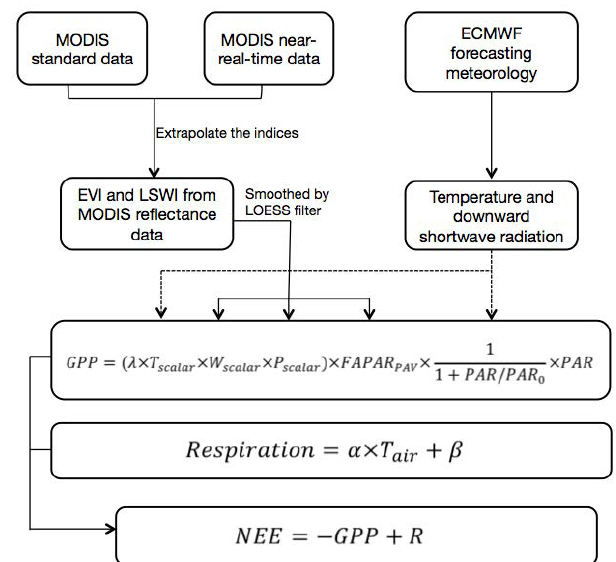
Figure 1. Diagram of the VPRM forecasting system. The top two levels show the drivers which are predicted into the future, while the bottom three boxes are based on the standard VPRM model (Ma- hadevan et al.,